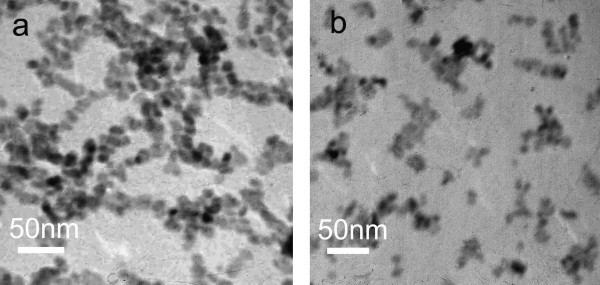
TEM images of CuO nanofluids prepared with different concentrations of (CH3COO)2Cu·H2O solution. (a) 0.1 mol·l-1; (b) 0.4 mol·l-1.